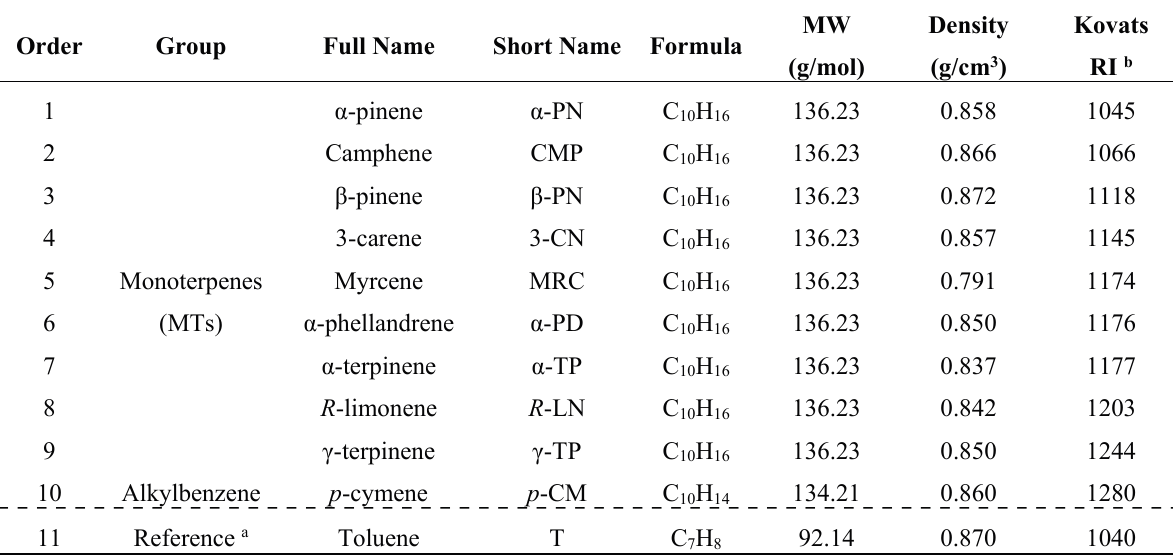
Table 1. Basic information of 10 monoterpenes (MTs) and a reference compound investigated in this